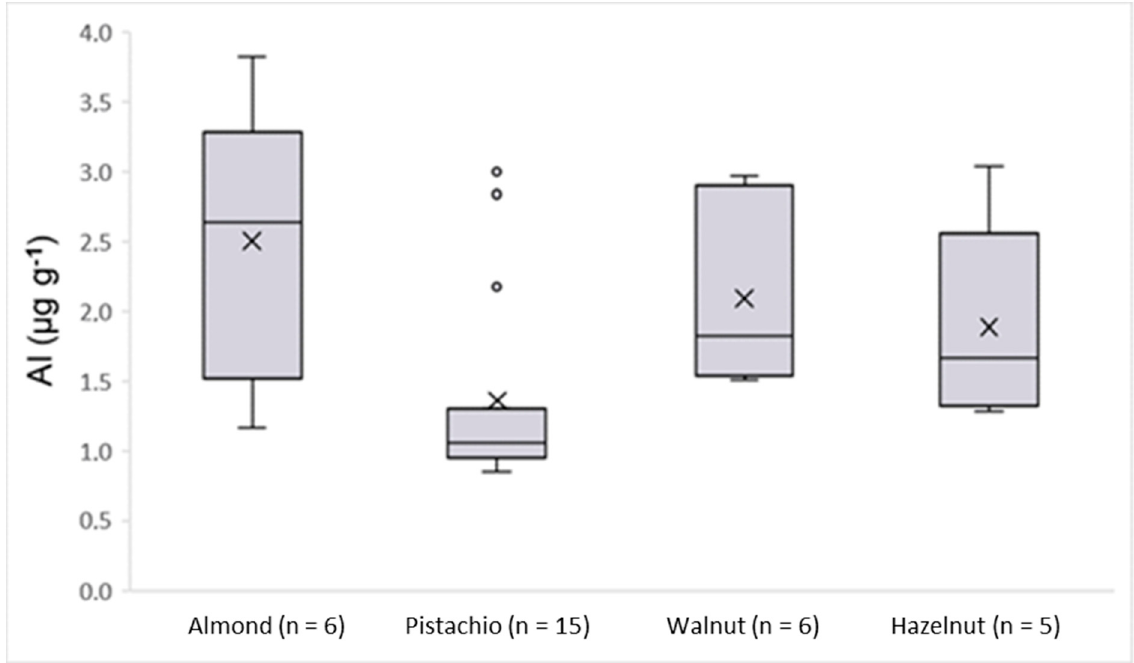
Figure 5. Box and Whisker plot for the concentrations of aluminum among different nut species. Concerning the ANOVA analyses of copper and manganese, the average concen- trations did not show a statistically significant difference for both elements because the calculated p -values were equal to p = 0.06 and p = 0.43, respectively. Figure 6 demonstrates that the highest average concentration of copper was determined in almonds (10.9 μ g g − 1 ). The second highest average concentration of copper was determined in hazelnuts (8.32 μ g g − 1 ); 5.15 μ g g − 1 were determined in pistachios and 2.62 μ g g − 1 were determined in walnuts.